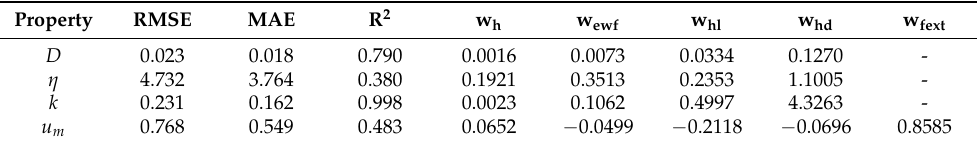
Table 4. Prediction accuracy and regression coefficients for each